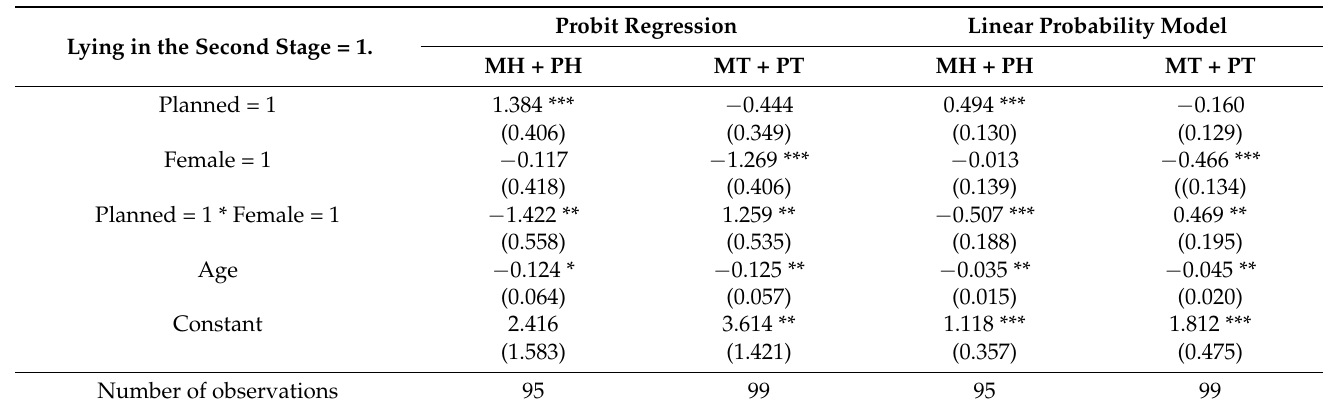
Table 5. Regression analyses: Lying in the second stage. Lying in the Second Stage =